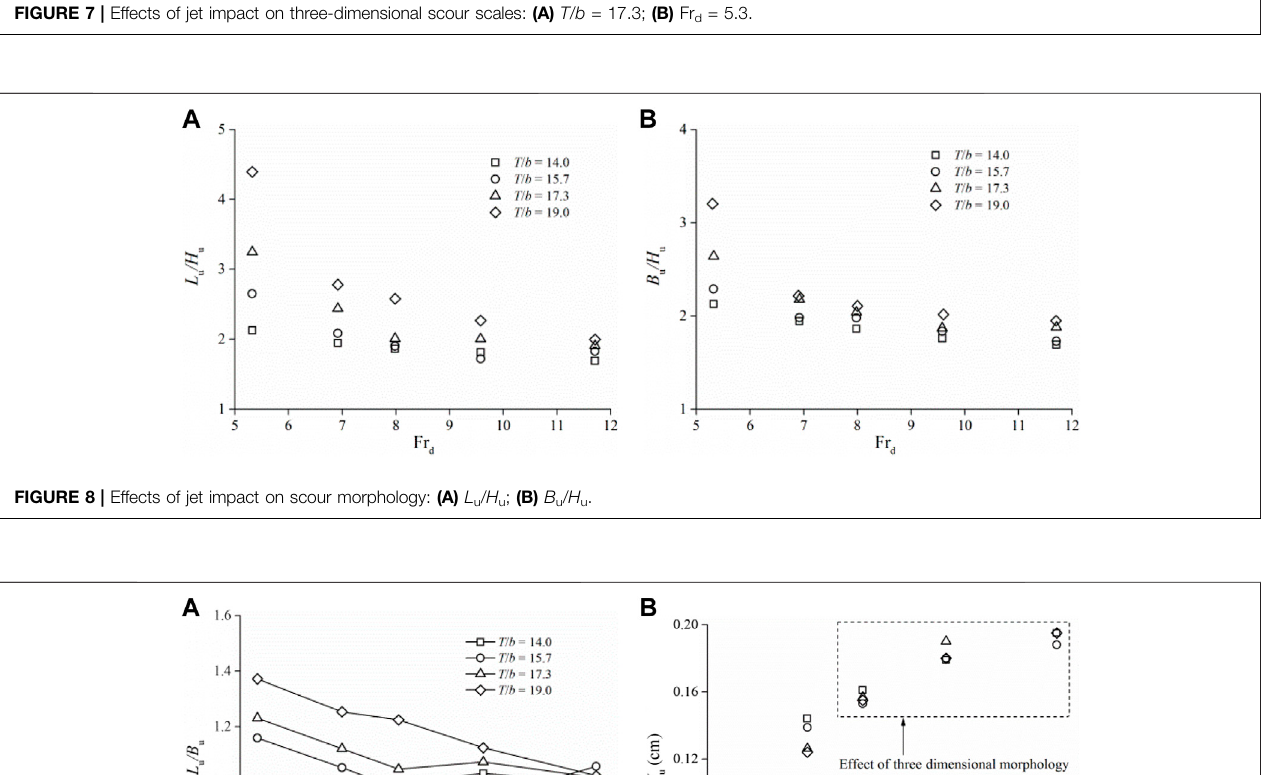
Frontiers in Earth Science |